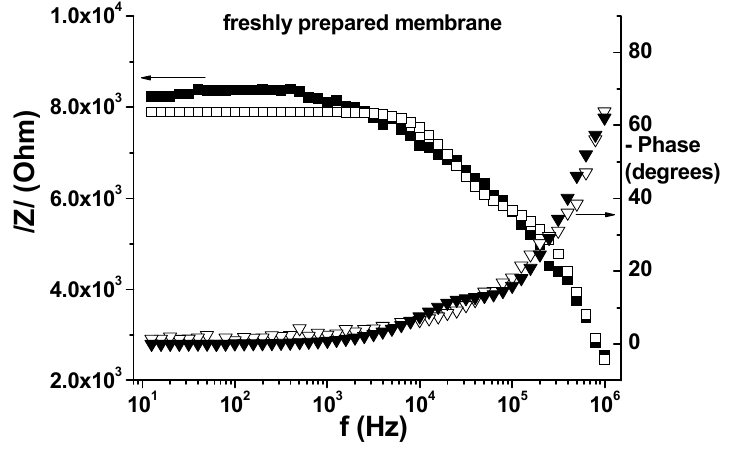
Figure 8. Bode plot for the freshly prepared membrane; the open symbols represent the fit of the experimental data, based on the electrical circuit presented in Figure 6.